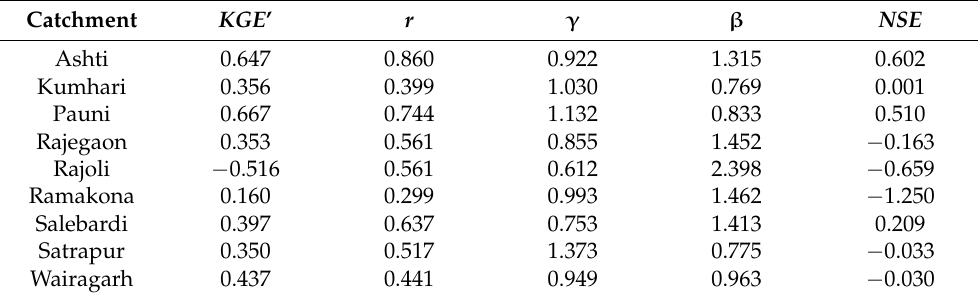
Table 4. Performance metrics (lumped sub-catchment modeling, optimizing performance on AMAX